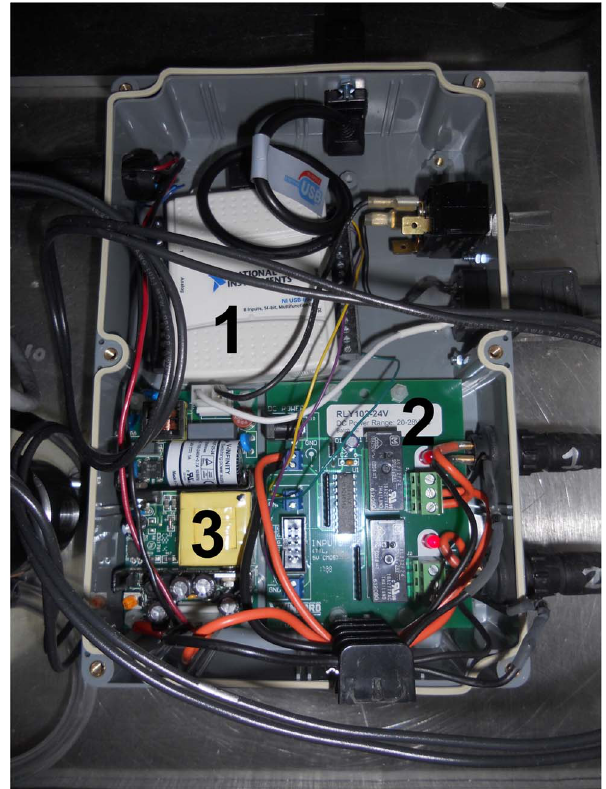
Figure 5. Detailed photograph of the electronics control system: the USB interface (1), relay board (2), and 24 VDC power supply (3).